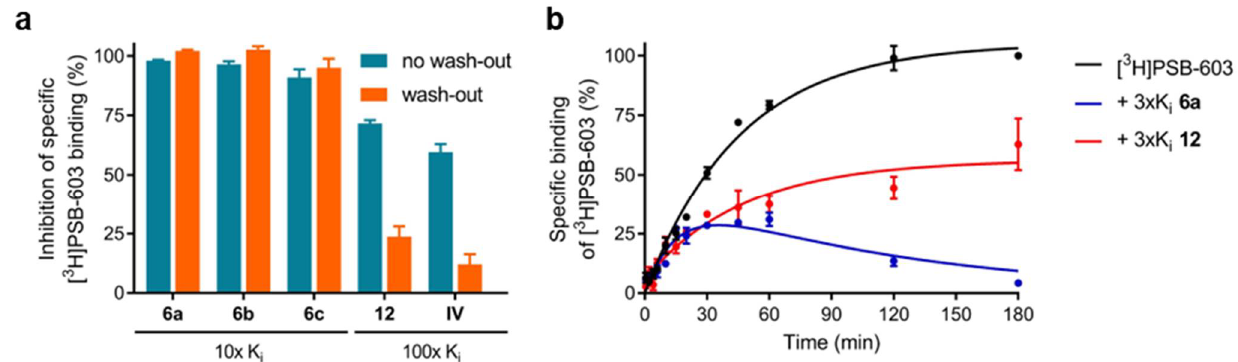
Figure 3. Assessment of reversibility of ligand binding. ( a ) Wash-out experiments after incubation of wildtype (wt) human A 2B AR with compounds 6a–c , 12 and IV at indicated concentrations. After an extensive washing procedure, specific binding of [ 3 H]PSB-603 was determined. Data represents normalized mean values ± SEM from three independent experiments. ( b ) Competition association of [ 3 H]PSB-603 alone (control) and in the presence of 6a or 12 in concentrations representing 3-fold of the respective apparent K i values. Values represent means ± SEM from two independent experi- ments.